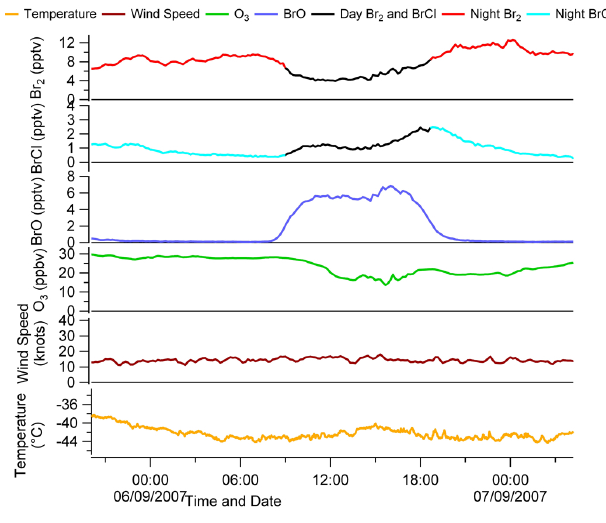
Fig. 1. Wind speed, temperature , surface O 3 , and CIMS Br 2 , BrCl and BrO measurements from Halley on 6–7 September 2007. Br 2 and BrCl daytime measurements are coloured